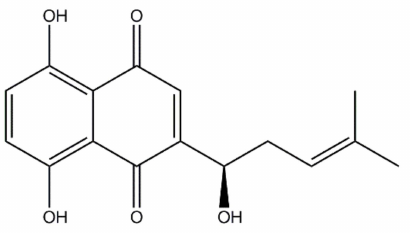
Figure 1. The chemical structure of shikonin